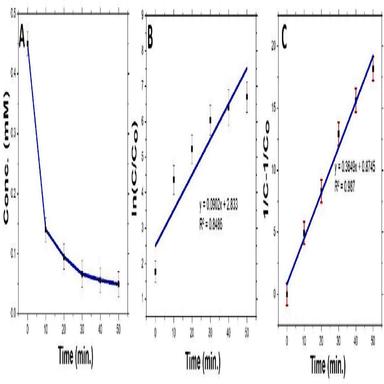
(A) H2O2 decomposition rate under dark conditions by Co-BDC, (B) fitting by pseudo-first-order modelling, and (C) fitting by second-order modelling.